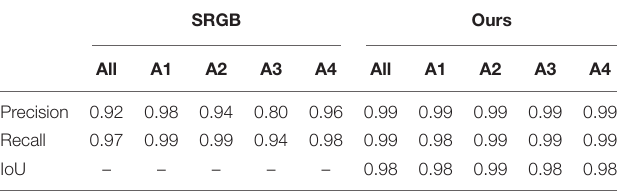
TABLE 3 | Segmentation results on each sub-dataset and their combination using different basic architectures. SRGB Ours